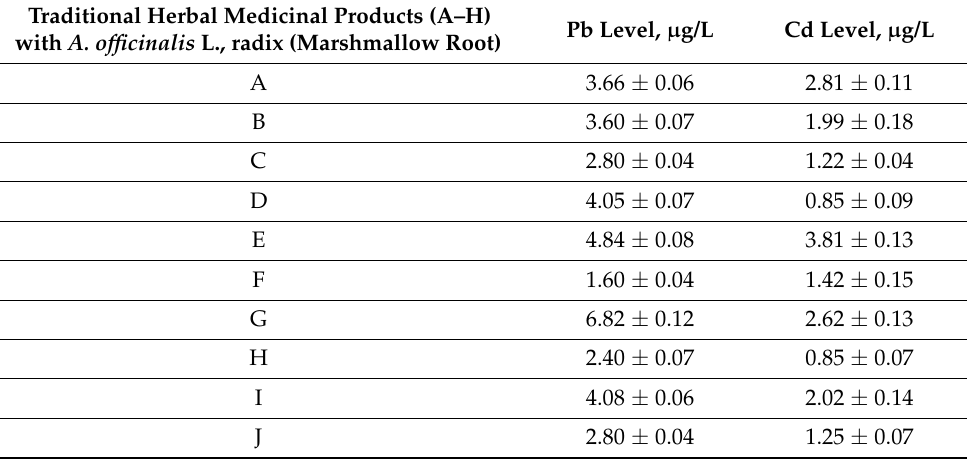
Table 4. The results of Pb and Cd impurities in analyzed THMPs (A–H) with A. officinalis L., radix (marshmallow root) from Polish pharmacies as raw results.